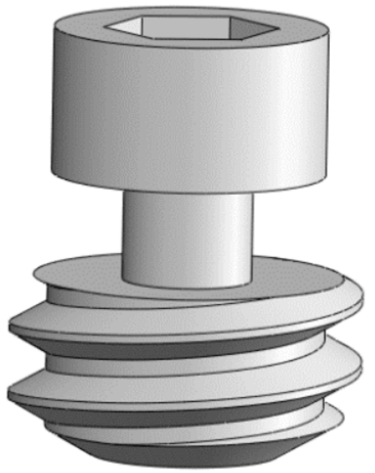
Figure 2. Deployment screw.